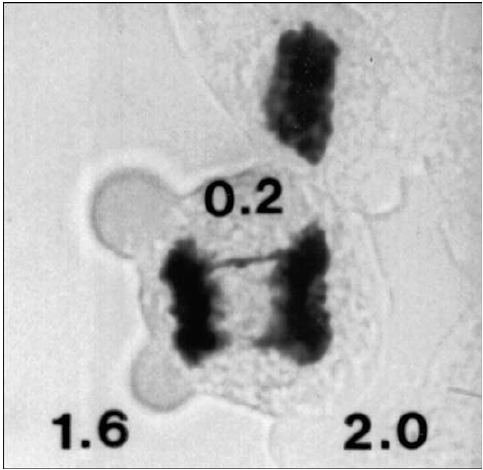
Fig. 5. Source of aneuploidy: successful telophase. Errant, lagging and sticky chromosomes are most frequent (values DNA content